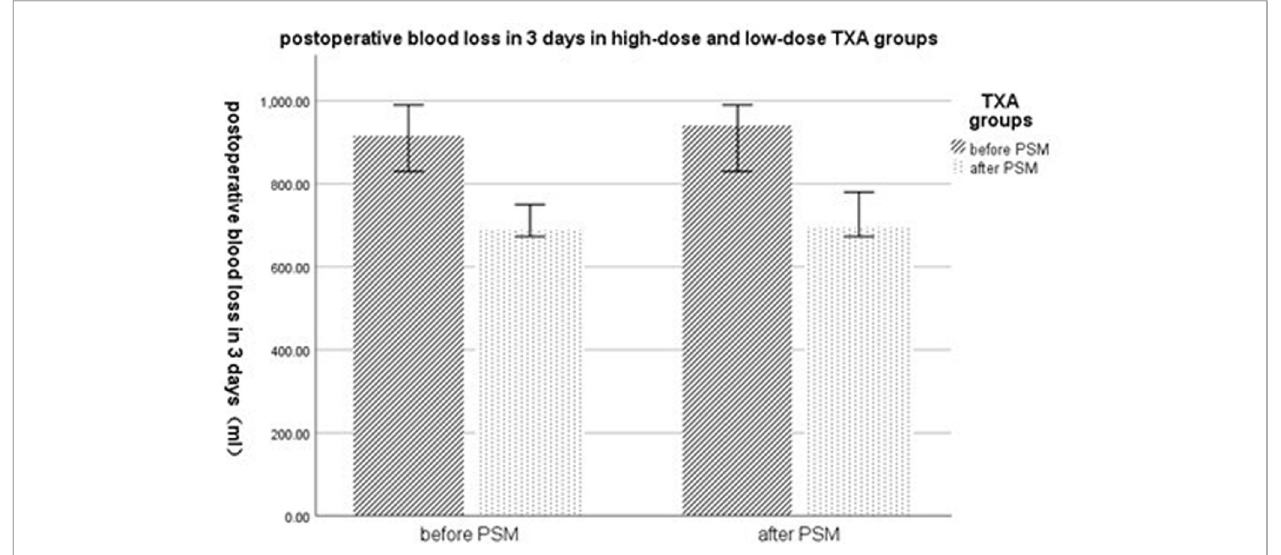
FIGURE 3 | Postoperative blood loss within 3 days in low-dose and high-dose TXA groups. TXA, tranexamic acid; PSM, propensity score